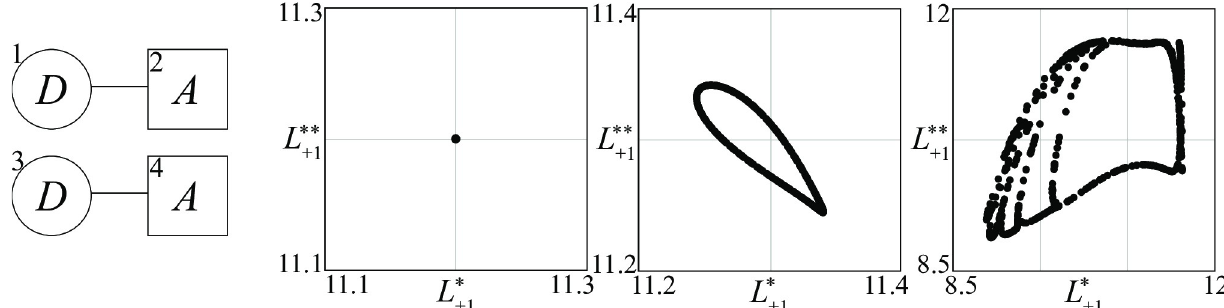
Fig 25. Two independent D — A conflict ( a ) and three PPP’s of the second D – A conflict for three increasing values of the spreading of the enthusiasm for attack strategies: ( a ) σ = 0; ( b ) σ = 0.005; ( c ) σ = 0.06.